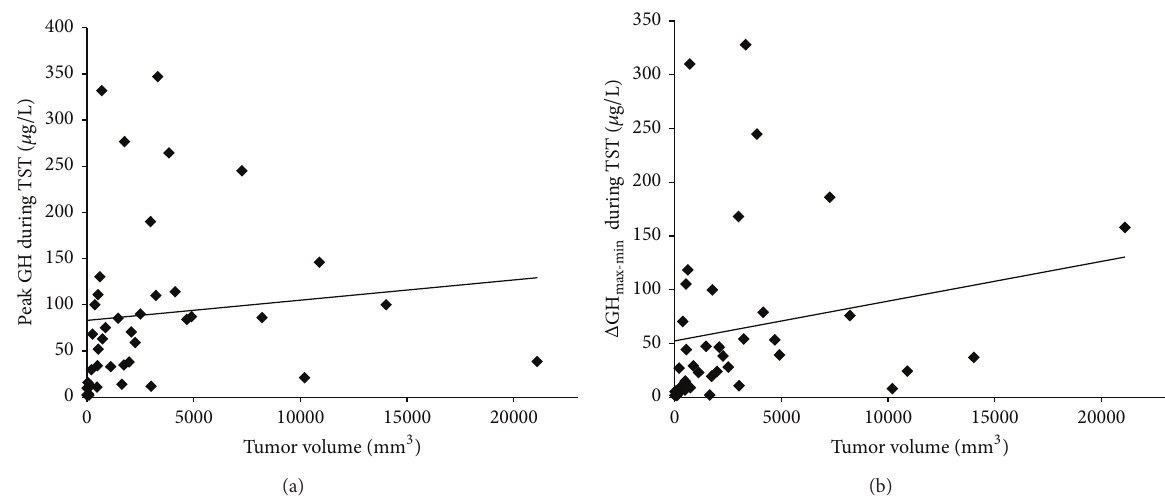
Figure 3: Correlation between the tumor volume and peak GH levels during the TST ( 𝑟 = 0.498 , 𝑃 = 0.001 ) (a) and Δ GH TST ( 𝑟 = 0.420 , 𝑃 = 0.006 )